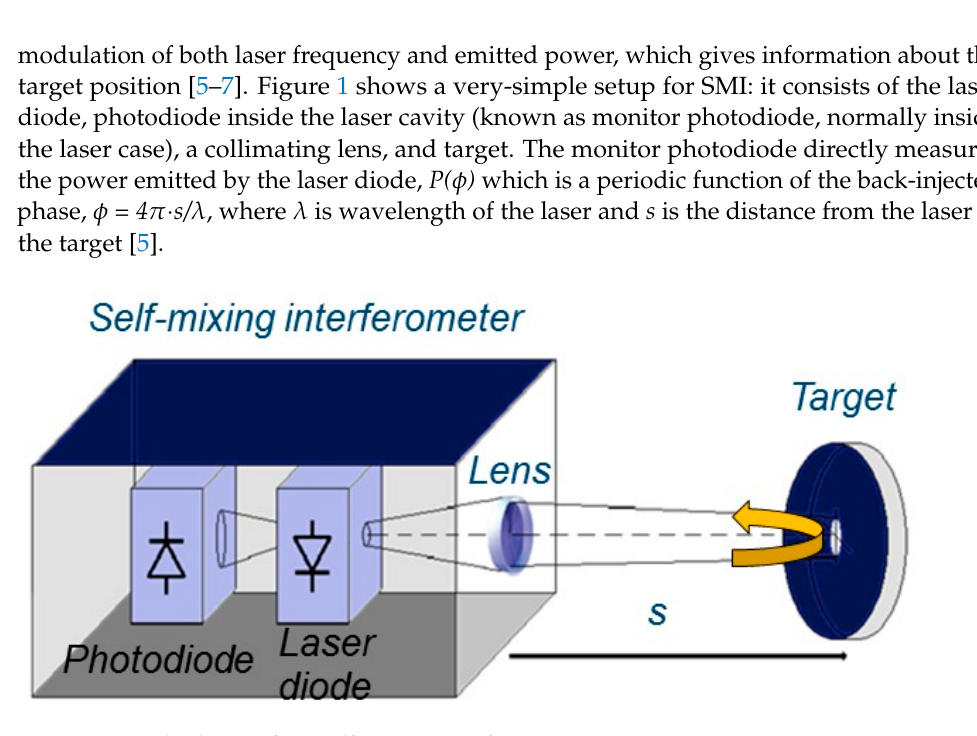
Figure 1. Standard setup for a self-mixing interferometer.